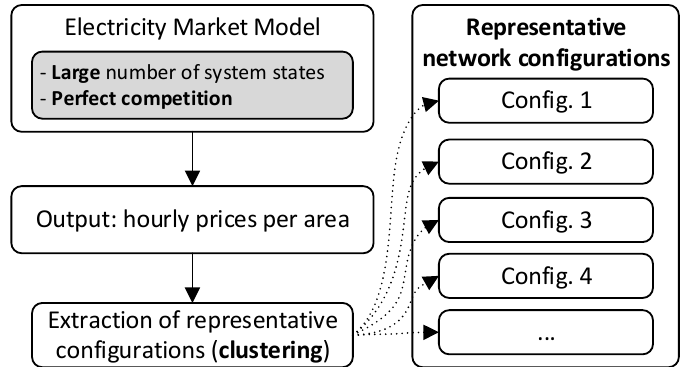
Figure 1. A diagram of Step 1 and Step 2 of the methodology.